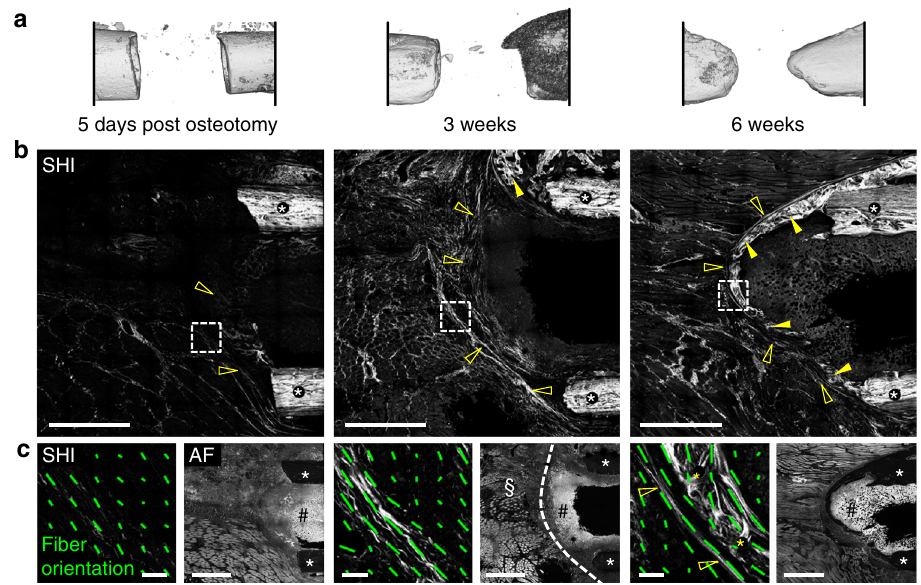
Fig. 1 Distinct collagen fi ber patterns forming in bone defect guide tissue mineralization. a 3D µ -CT reconstruction of the 5 mm rat femoral bone defect at different time points showing progression of tissue mineralization toward the formation of a bone-like shell closing the marrow cavity. b Second harmonic imaging showing the emergence of a fi brillar collagen matrix at the end of the bone (open arrowheads) preceding tissue mineralization (full arrowheads). White asterisks indicate the bone cortices. c Orientation analysis revealed that distinct patterns of collagen fi bers develop already in the fi rst days post osteotomy and mature towards a dense, dome-like structure until 3 weeks post-op (detailed SHI recordings at regions indicated by dashed-line squares in b ). Green lines indicate collagen fi ber anisotropy A C (length of line) and direction of primary fi ber orientation Φ C (angle) within the local ROIs. The formation of mineralized tissue (6 weeks, post-op, yellow asterisks) is guided by aligned collagen fi bers toward the formation of the marrow-closing bone shell. Auto fl uorescence imaging (AF) indicates the separation of the bone marrow and the periosteum (hash symbol) from the defect region (paragraph symbol) by the deposited collagen fi ber structure (dashed white line, 3 weeks post-op). Scale bars for b 1 mm; c SHI-images 50 µ m, AF images 1 mm